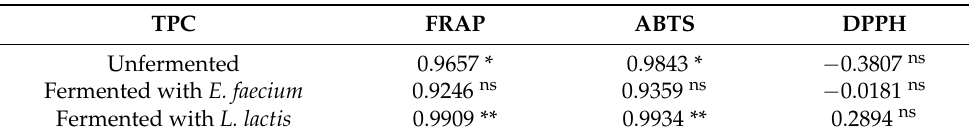
Table 5. Correlations between total phenolic content (TPC) and antioxidant activity (FRAP, ABTS, DPPH) of digested samples. TPC FRAP ABTS DPPH Unfermented 0.9657 * 0.9843 * − 0.3807 ns Fermented with E. faecium 0.9246 ns 0.9359 ns − 0.0181 ns Fermented with L. lactis 0.9909 ** 0.9934 ** 0.2894